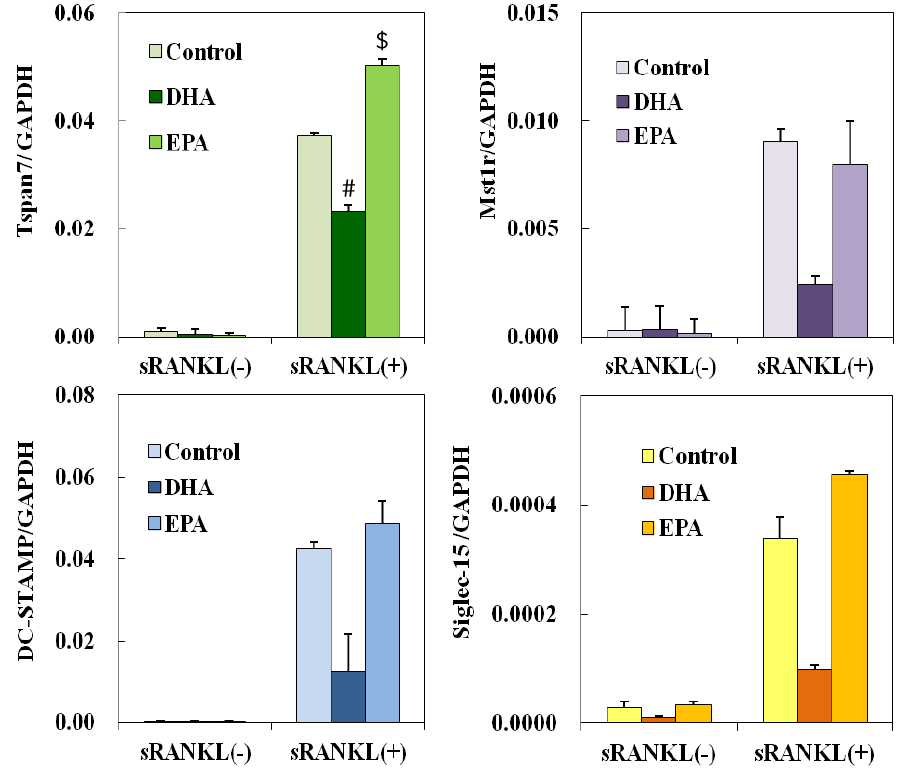
Figure 5. Effects of EPA on gene expression that was attenuated by the DHA treatment during osteoclastogenesis. DC-STAMP, Tspan7, Siglec-15 and Mst1r mRNA levels were normalized to that of GAPDH. Each column and bar represents the mean ± SE of three mice. # Significantly different from EPA-treated group ( p < 0.05) by Tukey-Kramer’s